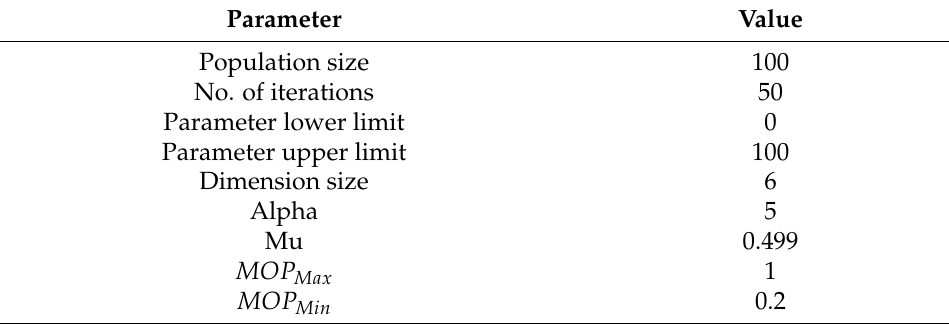
Table 1. Optimization parameters